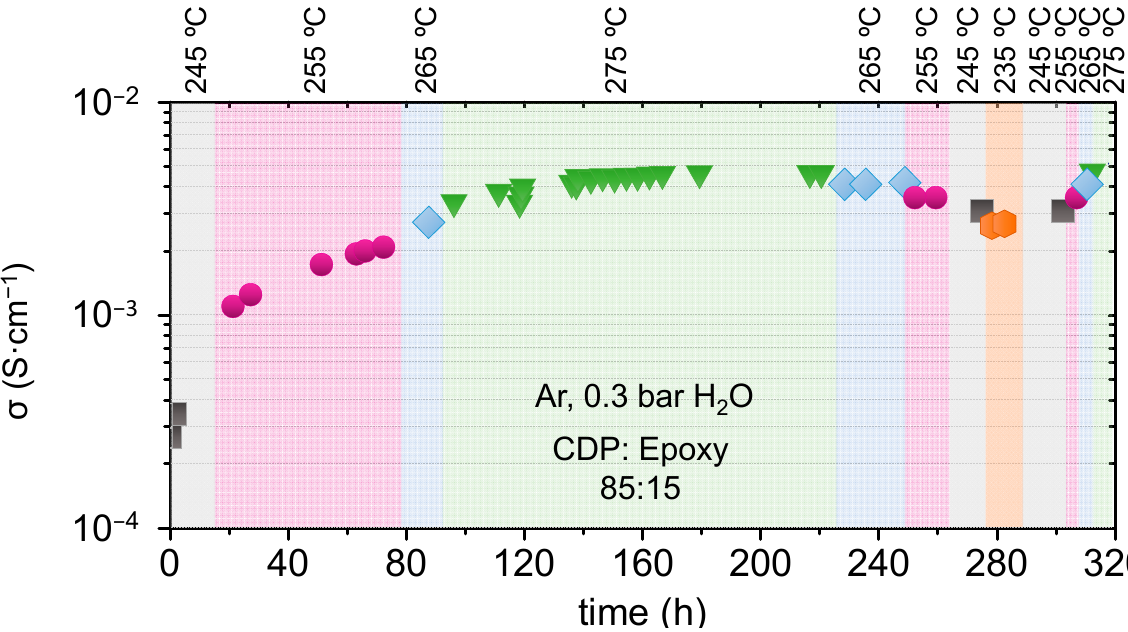
Figure 4. CDP: Epoxy 85:15 material conductivity measured as function of time for different temperatures with pH 2 O 0.3 bar in Ar.